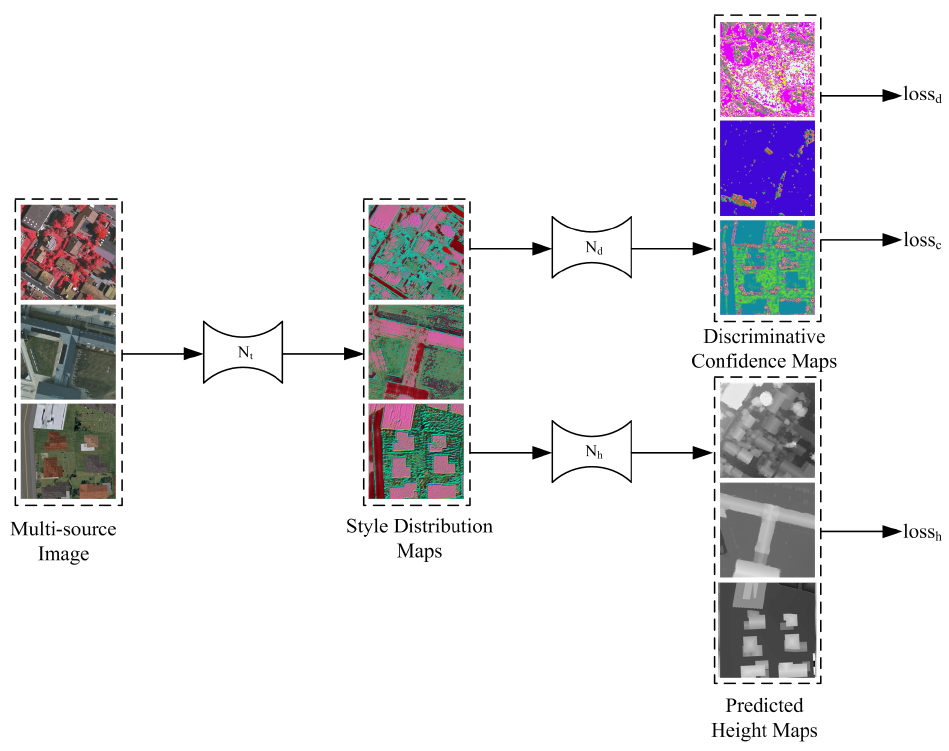
Figure 1. Pipeline overview. The framework contains three sub-networks: style transferring sub- network ( N t ), height regression sub-network ( N h ), and style discrimination sub-network ( N d ). They work together to complete the task of semi-supervised height